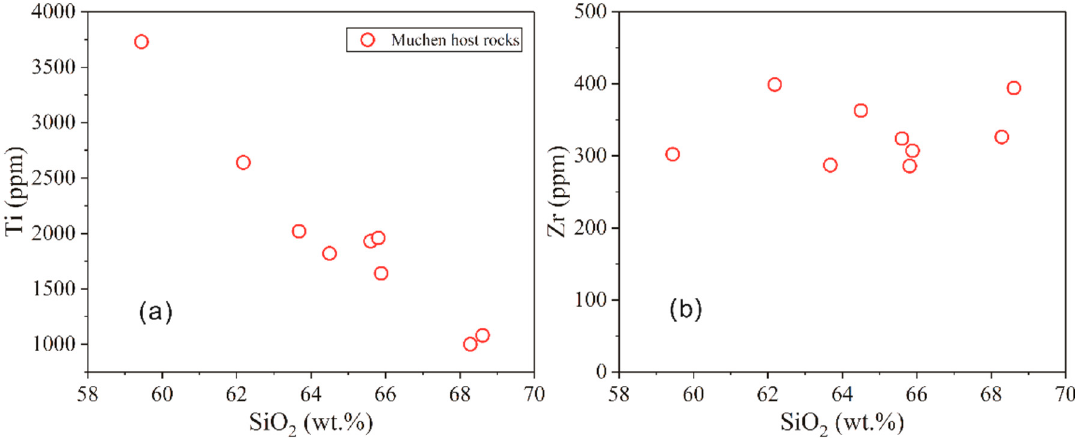
Figure 13. ( a ) SiO 2 vs. Ti and ( b ) SiO 2 vs. Zr diagrams for Muchen quartz monzonites.